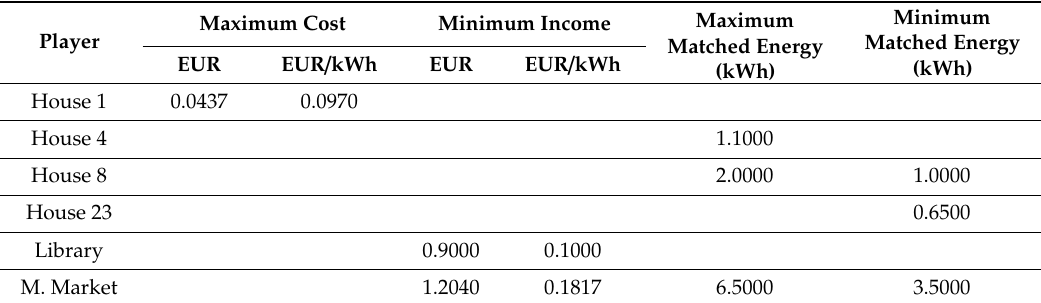
Table 4. Players’ session constraints.